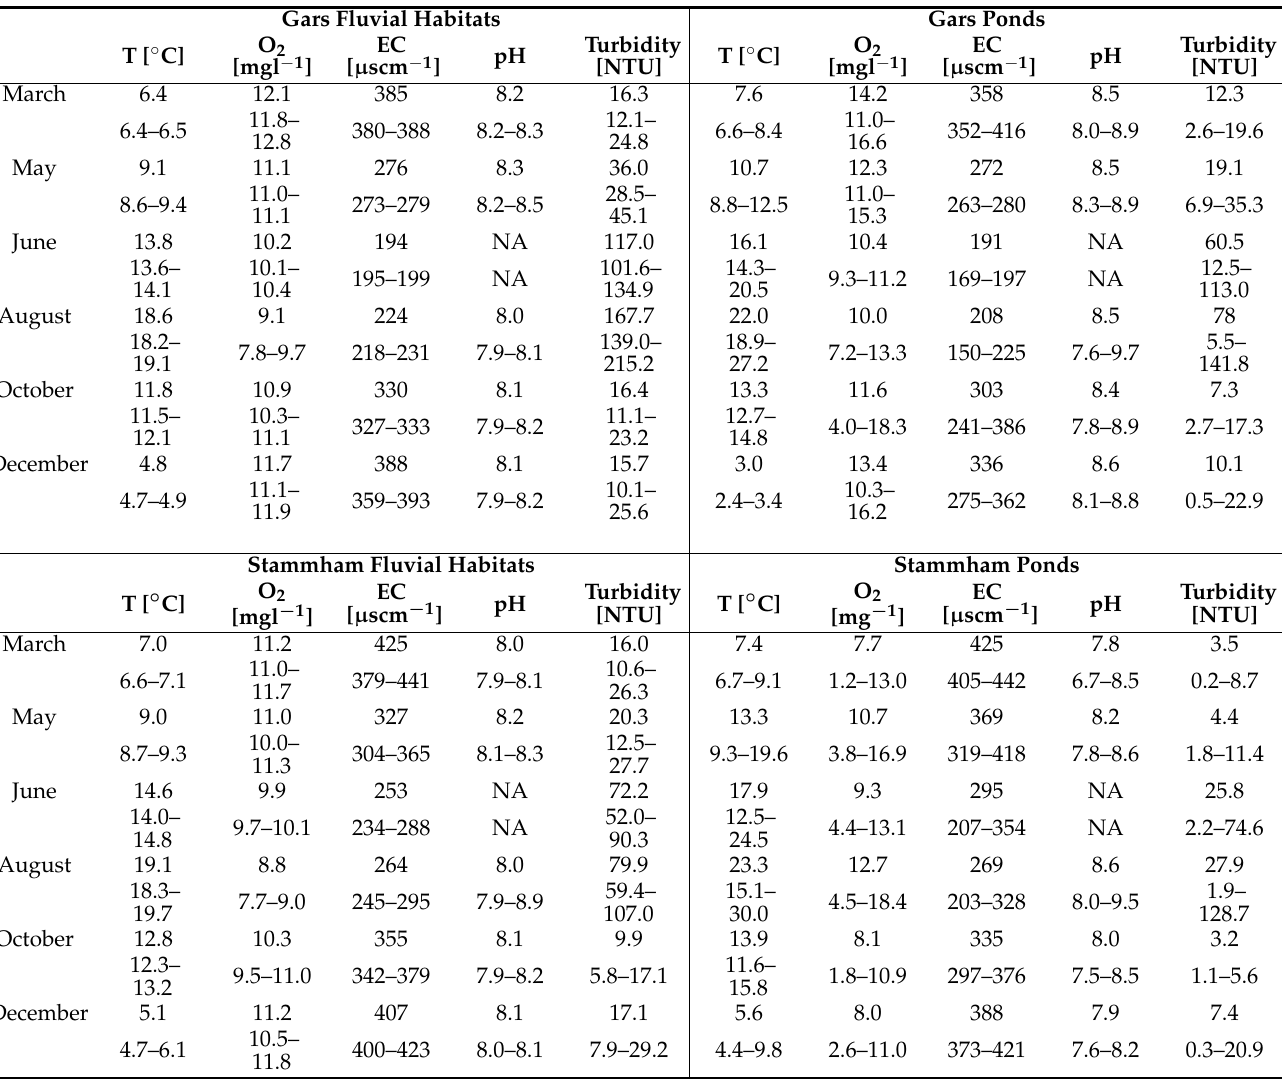
Table 4. Abiotic habitat variables measured in the two fish passes Gars and Stammham throughout the study period. Values represent Scheme 2. O 2 = dissolved oxygen, EC = electric conductance, pH, and turbidity. NA = not available. Gars Fluvial Habitats Gars